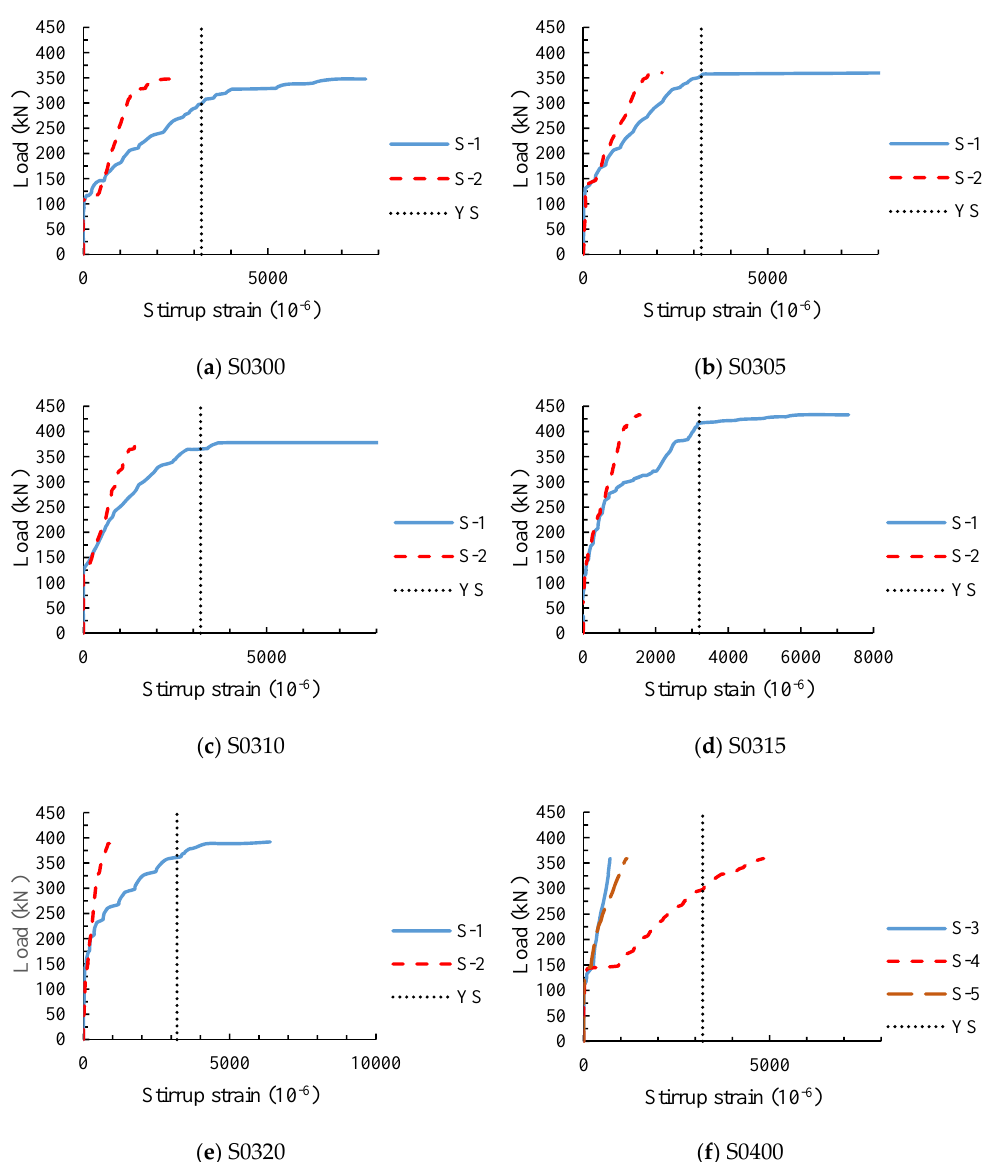
Figure 7. Load-stirrup strain curves of specimens (YS: yielding strain). ( a ) Beam S0300; ( b ) Beam S0305; ( c ) Beam S0310; ( d ) Beam S0315; ( e ) Beam S0320; ( f ) Beam S0400.